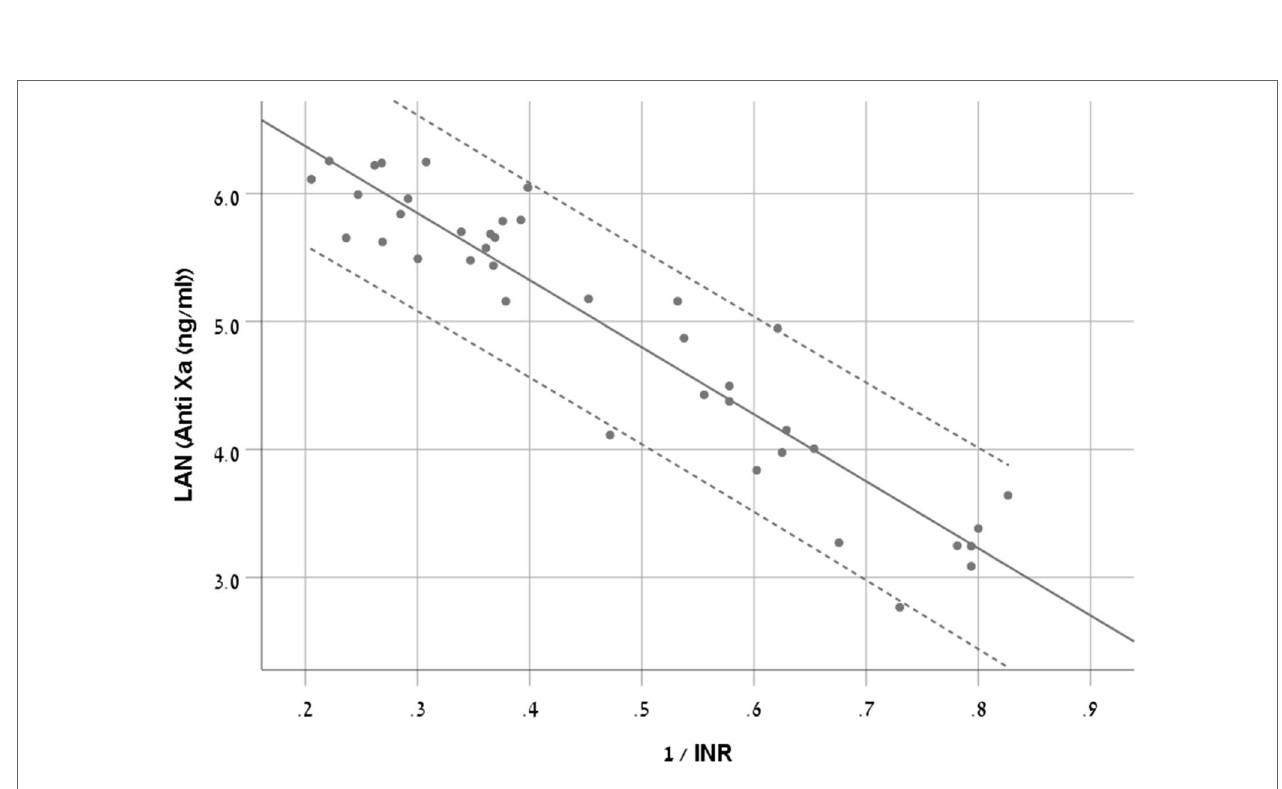
FIGURE 2 | A scatter plot demonstrating the new equation with 95% CI in patients treated with